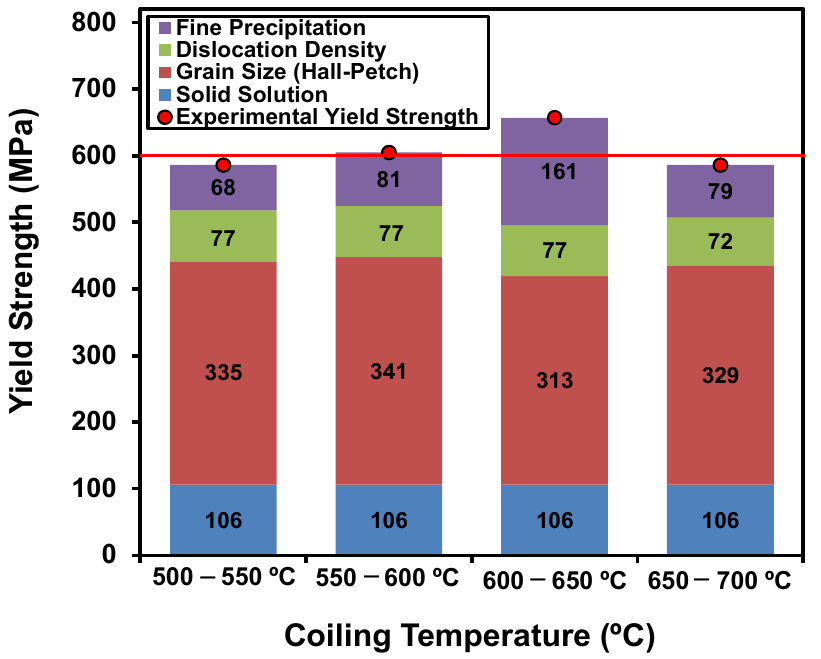
Figure 10. Contributions of different strengthening mechanisms to material yield strength. Samples 2, 3, and 4 were selected to analyze fine precipitation in the transmission electron microscope (TEM). TEM micrographs corresponding to Sample 3 (coiling temper- ature of 600–650 ◦ C) are shown in Figure 11, in which different precipitate populations can be distinguished deriving from different steps in the process. The coarsest precipitates (coarser than 30 nm) are usually associated with the lack of complete dissolution of Nb-rich particles during initial soaking. Precipitates ranging between 10 and 20 nm can be related to the strain-induced precipitation taking place in the austenite during finishing deformation passes (below T nr ). In addition, in Sample 3, very fine precipitates smaller below 10 nm were also detected, and these, which formed during cooling (run-out table or coiling), are effective in encouraging a hardening effect. The microanalysis performed in the different types of precipitates suggest that they were mainly Nb- and Ti-rich ones (see an example in Figure 11d).